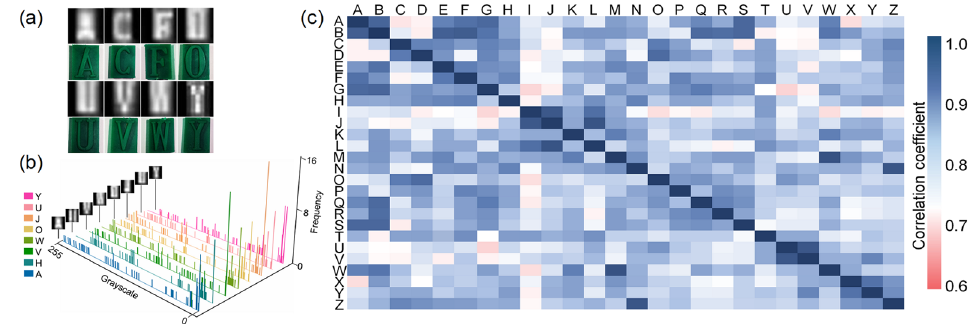
Figure 2. Nonideal effects of haptic images. ( a )The letter-shape samples obtained by a 32 × 32 sensor array, ( b ) the grayscale distribution histograms of the samples, ( c ) the Bhattacharyya coefficient of the 26 letter shapes.